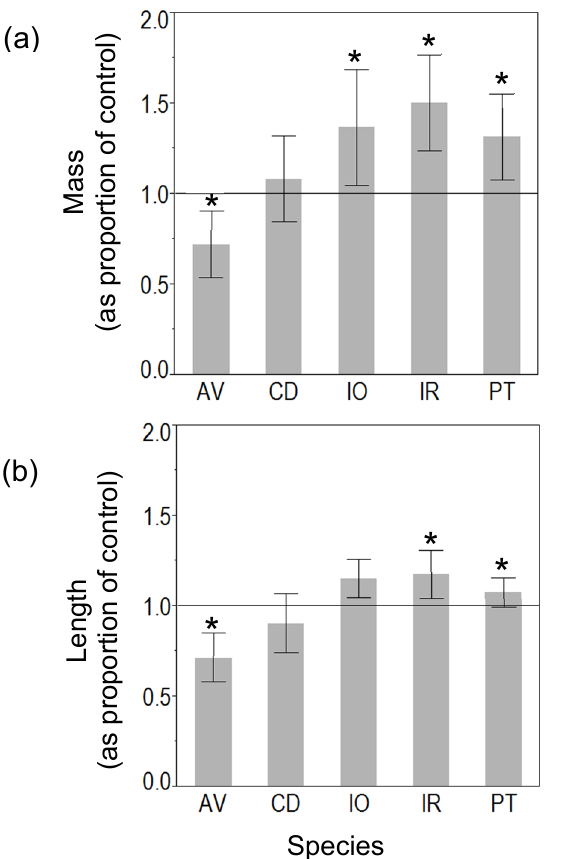
Figure 1. Effects of grazer species on eelgrass ( a ): mass and ( b ) shoot length at the end of Phase 1 of the mesocosm experiment. Error bars are 95% CI. Asterisks indicate significant effects as determined by confidence intervals that do not overlap with the control value of 1. Species and sample sizes were AV = Ampithoe valida ( n = 26), CD = Caprella drepanochir ( n = 23), IO = Ilyanassa obsoleta ( n = 23), IR = Idotea resecata ( n = 26), and PT = Phyllaplysia taylori ( n =